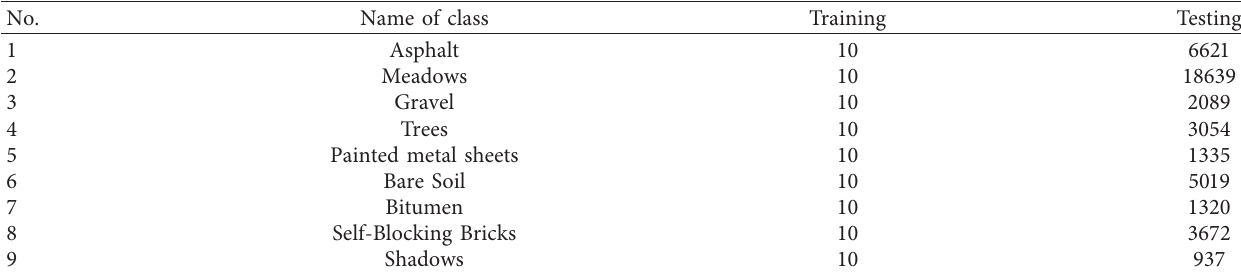
Table 3: The ground truth classes and their respective training and testing numbers of the Pavia University datasets. No.